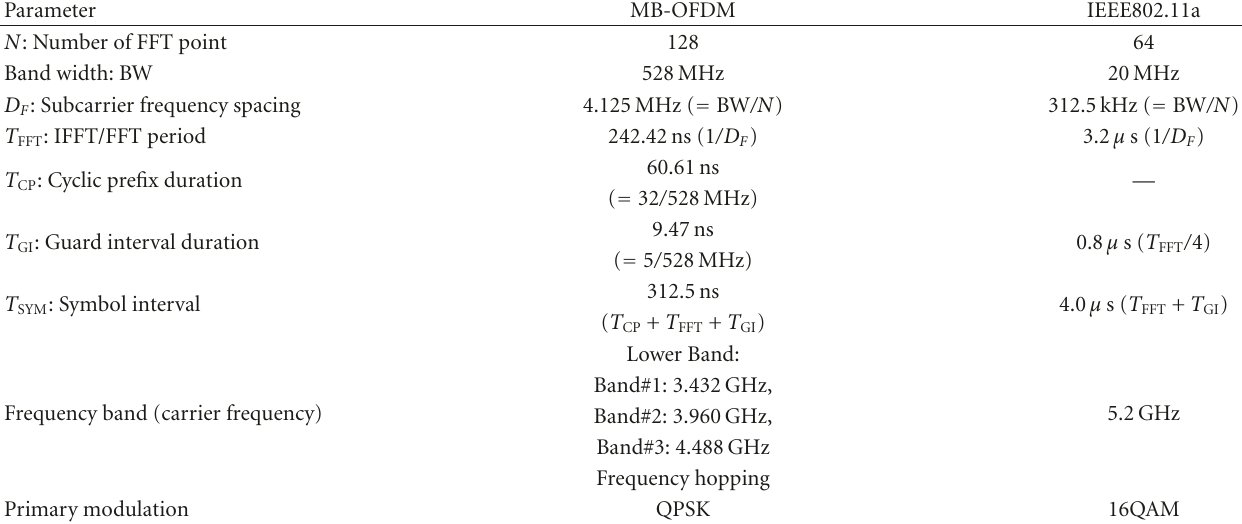
Table 1: Simulation parameters for MB-OFDM and